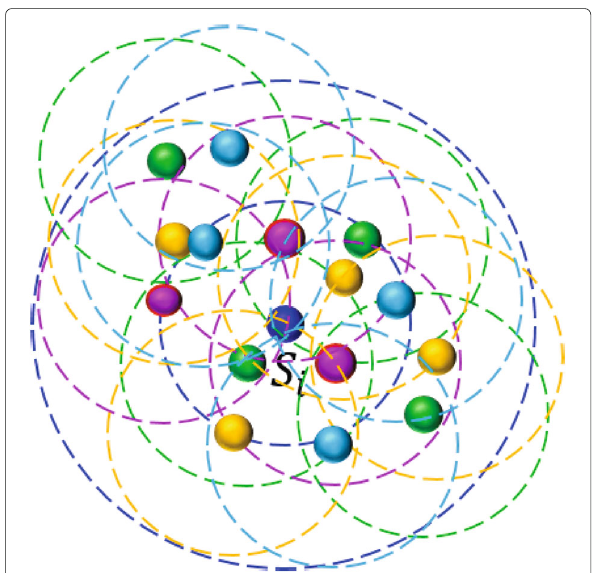
Fig. 5 Illustration of cover sets of s i